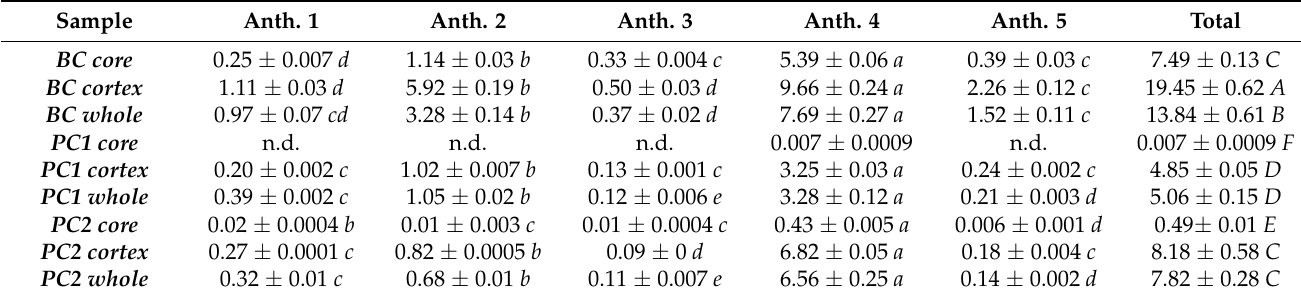
K Eq. = kuromanin (cyanidin 3-glucoside) equivalent. n.d. = not determined. Anth. 1 : cyanidin 3-xylosyl (glucosyl) galactoside. Anth. 2 : cyanidin 3-xylosyl galactoside. Anth. 3 : sinapic acid derivative of cyanidin 3-xylosyl (glucosyl) galactoside. Anth. 4 : ferulic acid derivative of cyanidin 3-xylosyl (glucosyl) galactoside. Anth. 5 : coumaric acid derivative of cyanidin 3-xylosyl (glucosyl) galactoside. Data are the means ± SDs ( n = 3). Different lowercase letters in the same row, or uppercase letters in the last column, indicate statistically significant differences at p ≤